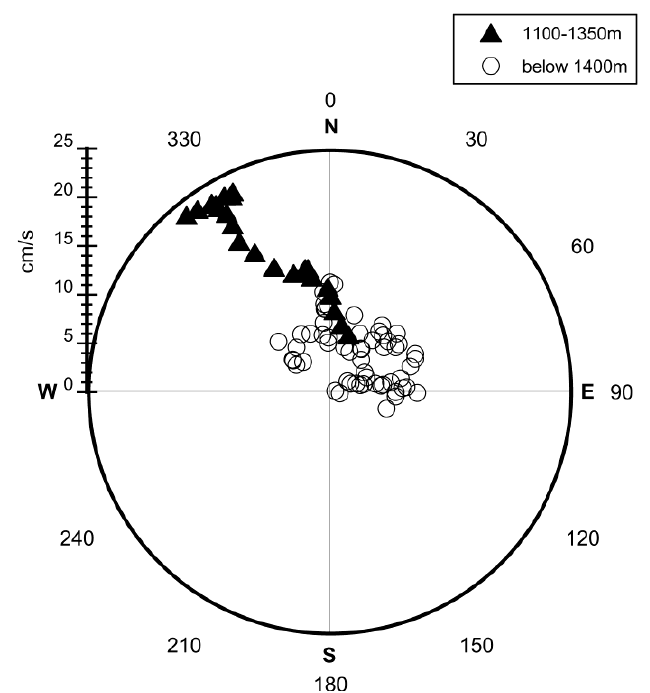
Figure 3. Mean-lowered Acoustic Doppler Current Profiler (LADCP) data obtained from multiple vertical CTD casts at Brothers volcano. The displayed data is separated in the two depth intervals 1100 m–1350 m and deeper than 1400 m.